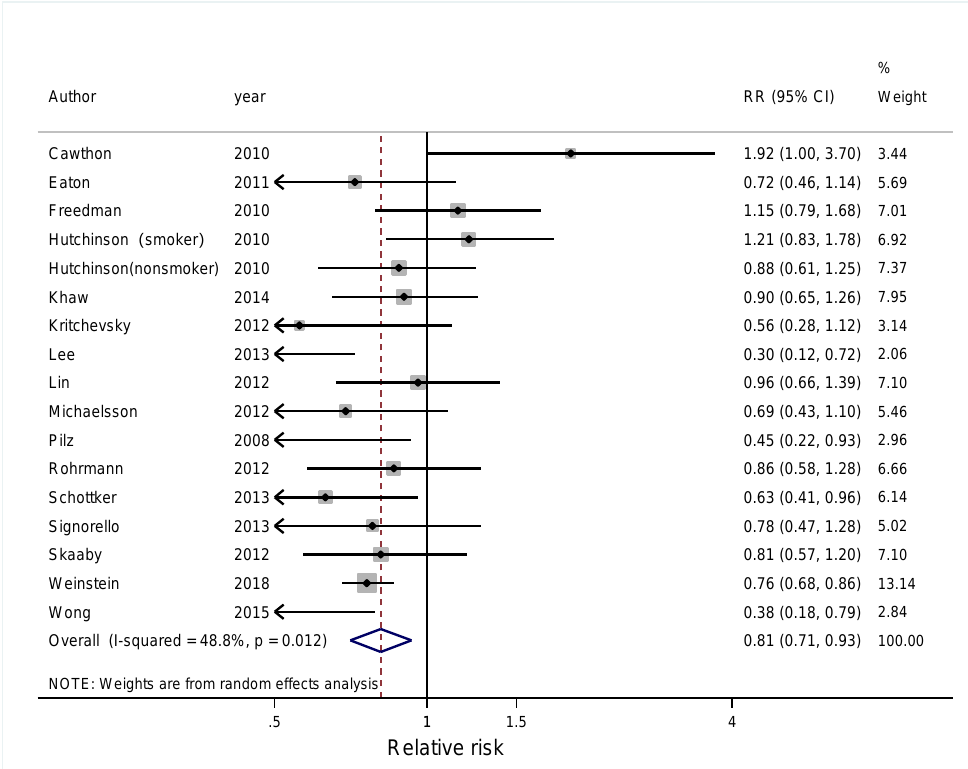
Overall (I-squared = 48.8%, p = NOTE: Weights are from random effects analysis